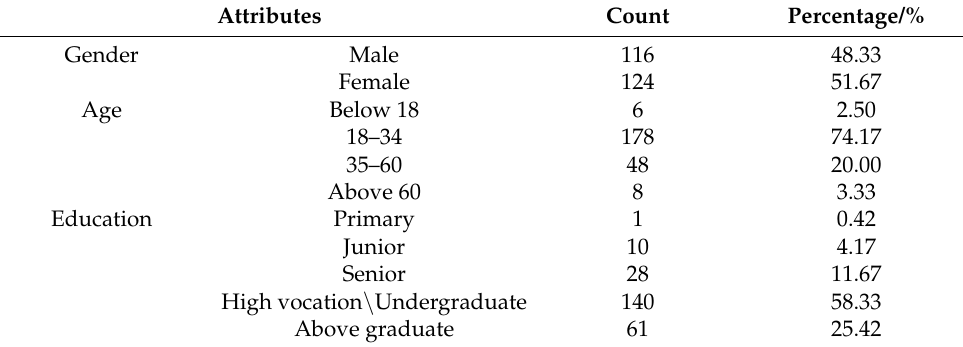
Table 3. Basic situation of the respondents (N = 240).